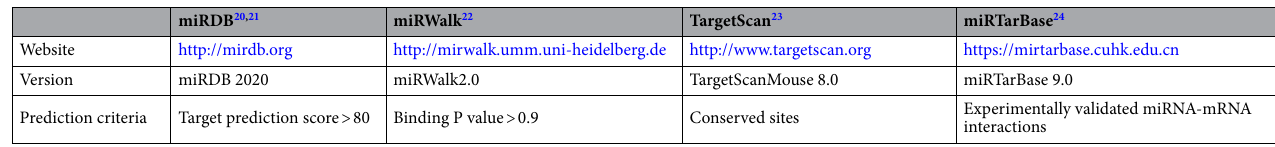
Table 1. MiRNA target prediction